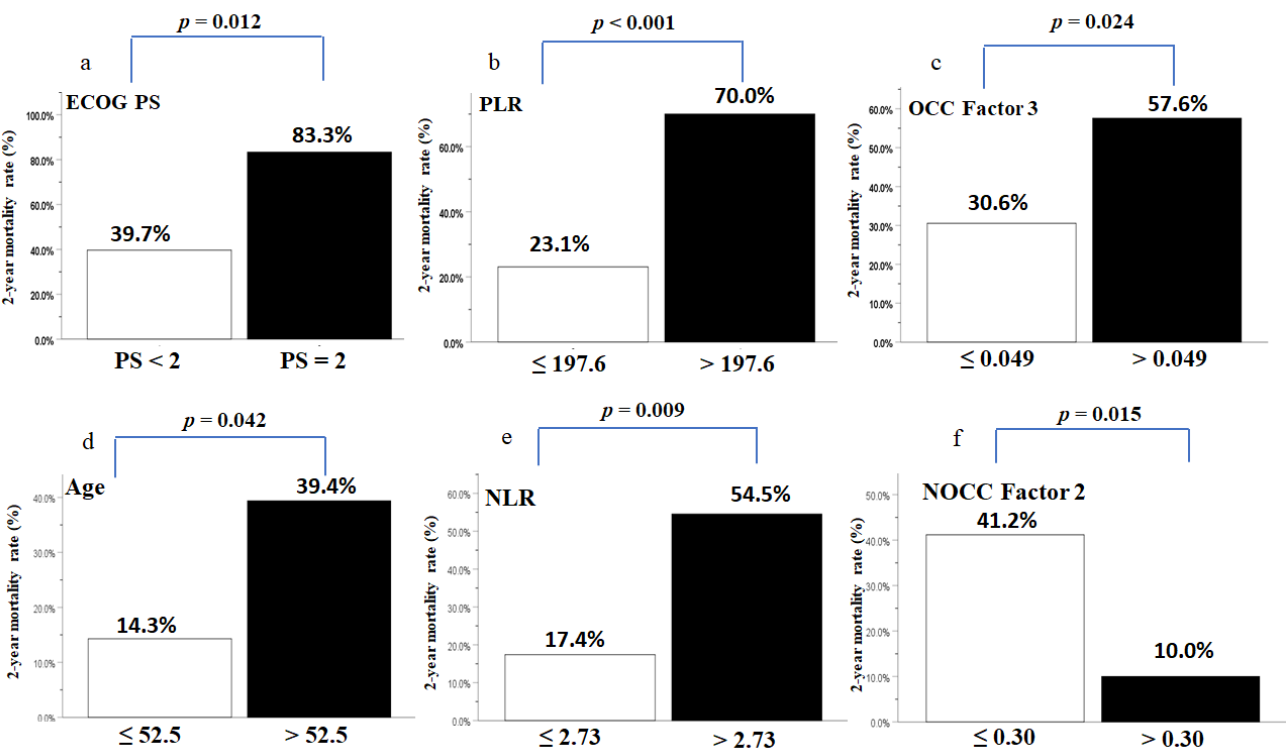
Figure 3. ( a – c ) Two-year mortality rates of patients with OCC with postoperative adjuvant CCRT stratified by ECOG PS (performance status), PLR, and OCC Factor 3 (change in body muscle mass during CCRT); ( d – f ) two-year mortality rates of patients with NOCC with primary CCRT stratified by age, NLR, and NOCC Factor 2 (body fat mass before CCRT). OCC, oral cavity cancer; NOCC, non-oral cavity cancer; NLR, neutrophil-to-lymphocyte ratio; PLR, platelet-to-lymphocyte ratio. The cutoff value analyzed by ROC curves for PLR was 197.6 (area under the curve (AUC): 0.807, p < 0.001), that of OCC Factor 3 was 0.049 (AUC: 0.692, p = 0.01), that of age was 52.5 (AUC: 0.708, p = 0.017), that of NLR was 2.73 (AUC: 0.689, p = 0.037), and that of NOCC Factor 2 was 0.30 (AUC: 0.676, p = 0.046).